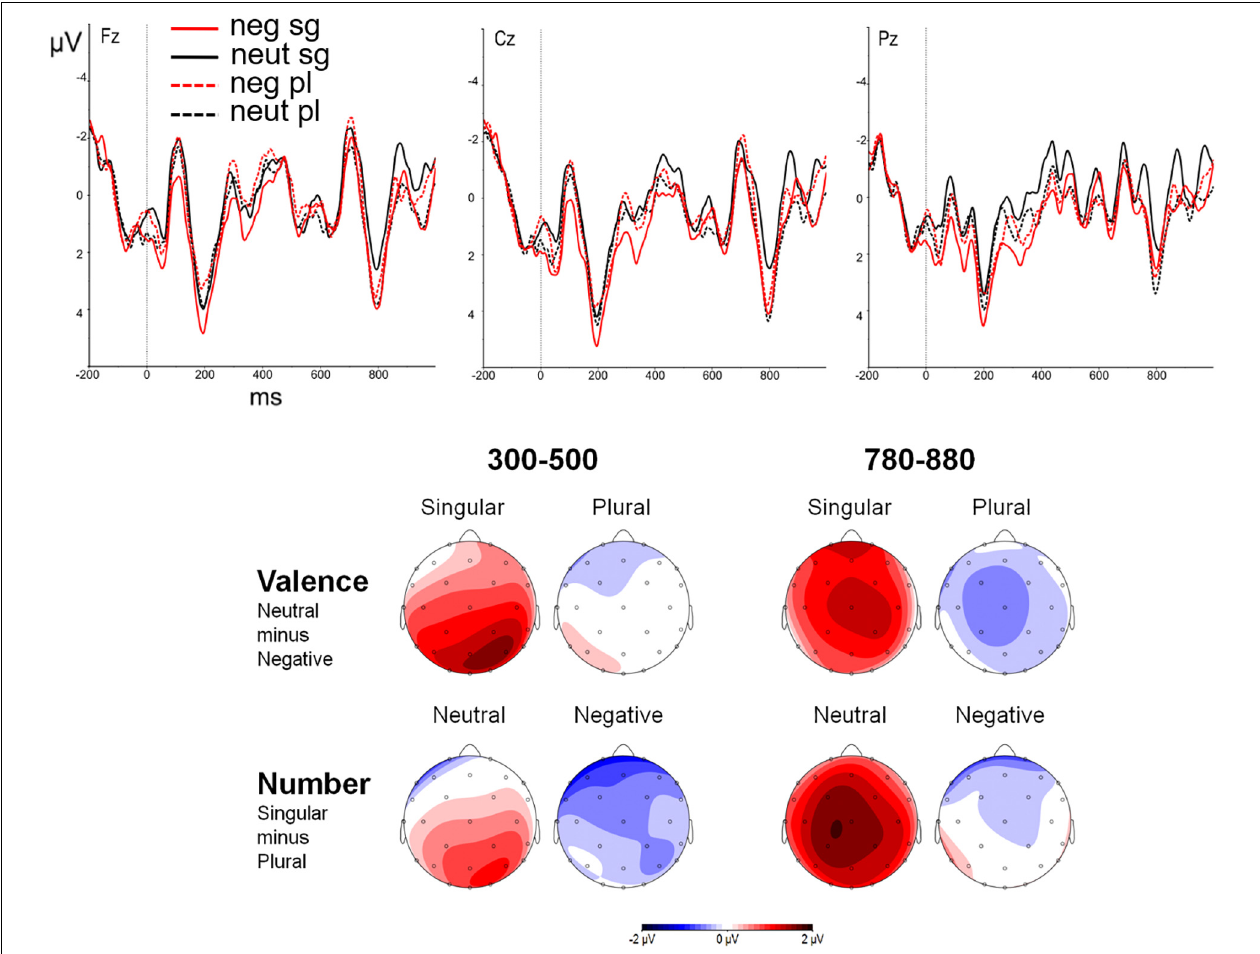
FIGURE 2 | Event-Related Potential (ERPs) to valence and number manipulations at the three midline electrodes (Fz, Cz, and Pz) and topographic maps in the verb (target) position in 300–500 and 780–880 ms